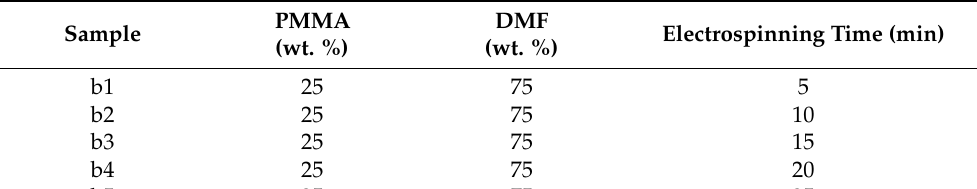
Table 1. Electrospun nanofilm sample compositions.